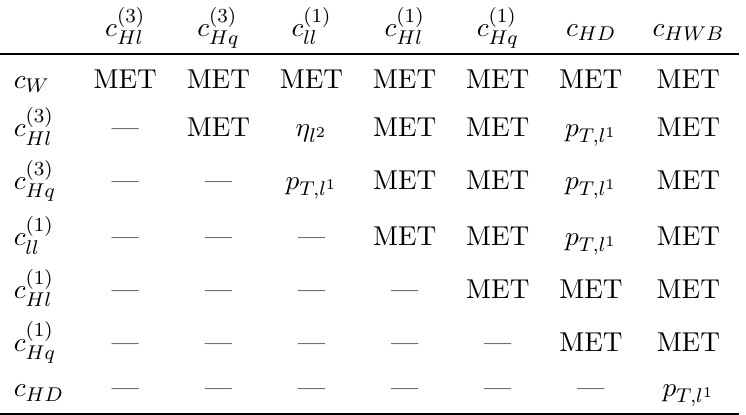
Table 10 . Most sensitive observable for each pair of SMEFT Wilson coefficients for 2D fits to diboson WW and including both linear and quadratic terms in the Wilson